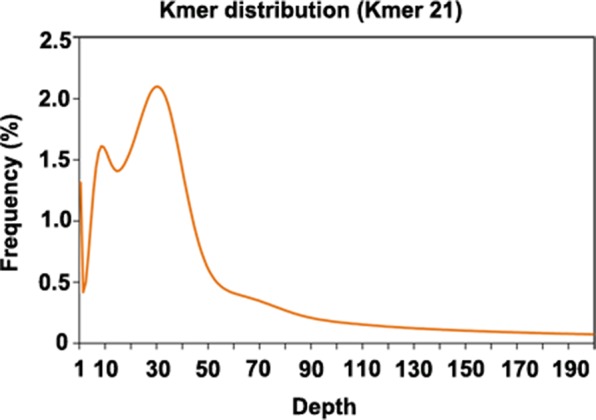
Kmer distribution of the genome survey result. The x-axis shows the depth of each Kmer, and the y-axis shows the frequency of each Kmer. In this analysis, all Kmers were 21 bp long.